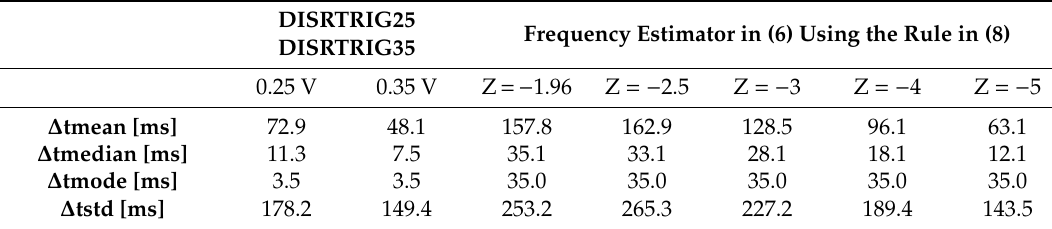
Table 3. Comparison of the statistical estimators of the log-distribution of the time intervals between the assertion time (“ ∆ t” in the table below) provided by either DISRTRIG25,35 or (6) with respect to the time instance of the disruption. DISRTRIG25 Frequency Estimator in (6) Using the Rule in (8) DISRTRIG35 0.25 V 0.35 V Z = − 1.96 Z = − 2.5 Z = − 3 Z = − 4 Z = − 5 ∆ tmean [ms]